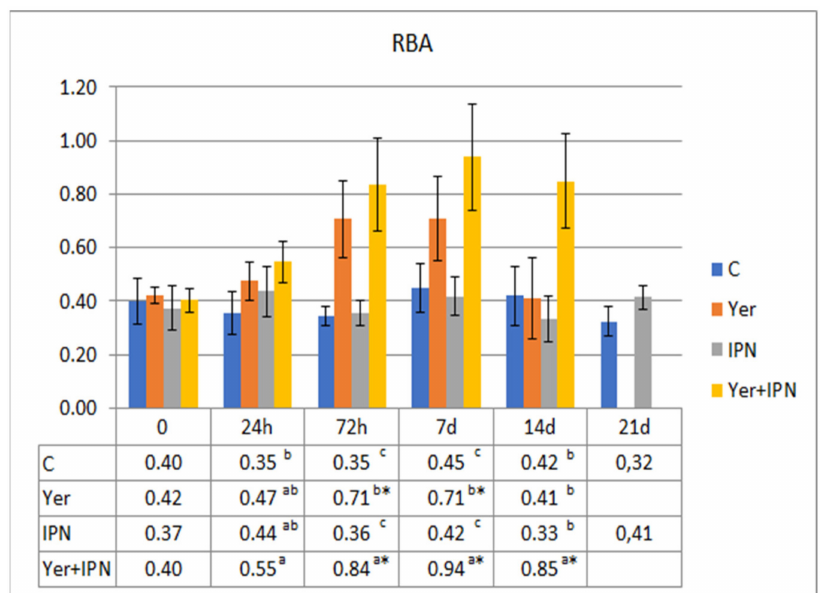
Figure 15. Mean values and standard deviation of metabolic activity of phagocytes over the course of the second experimental infection. *—statistically significant differences compared to the day 0 values within a given group ( p ≤ 0.05); a, b, c —statistically significant differences between the groups on a given sampling day ( p ≤